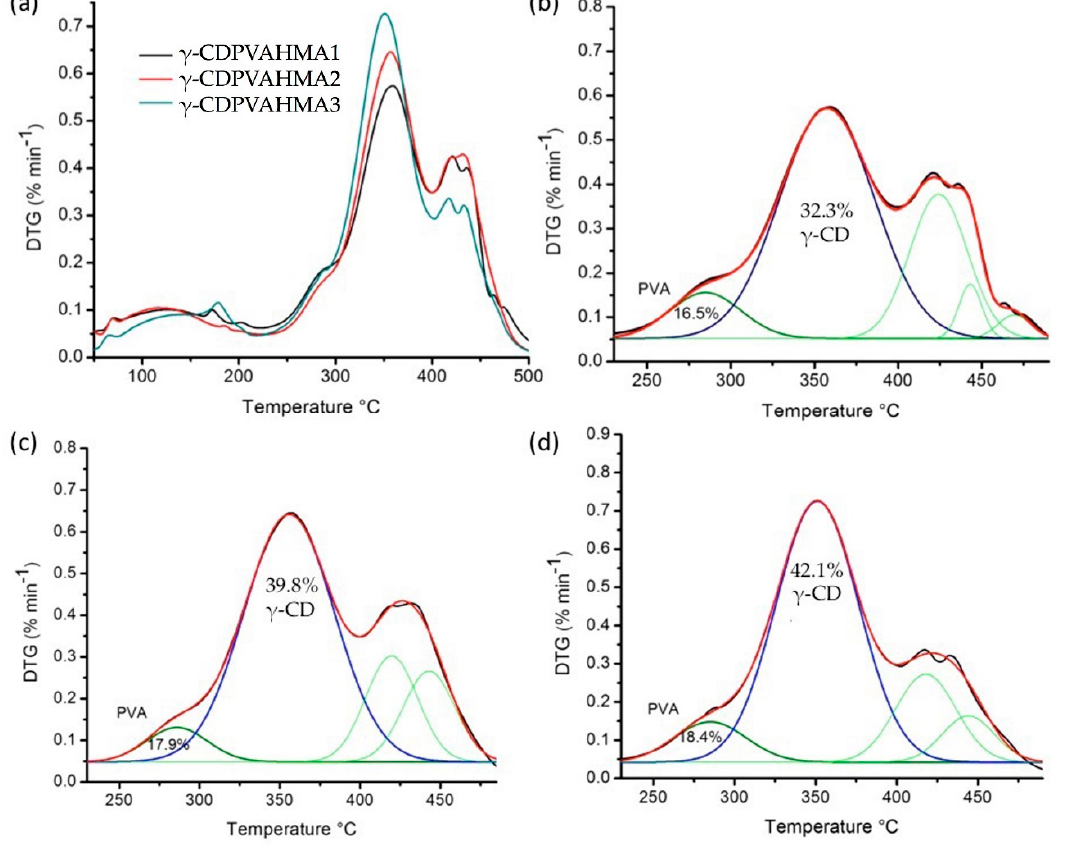
Figure 11. ( a ) DTG curves of γ -CDPVAHMAs and DTG and deconvolution curves of γ -CDPVAHMAs between 230 °C and 500 °C; ( b ) γ -CDPVAHMA1; ( c ) γ -CDPVAHMA2; and ( d ) γ -CDPVAHMA3.